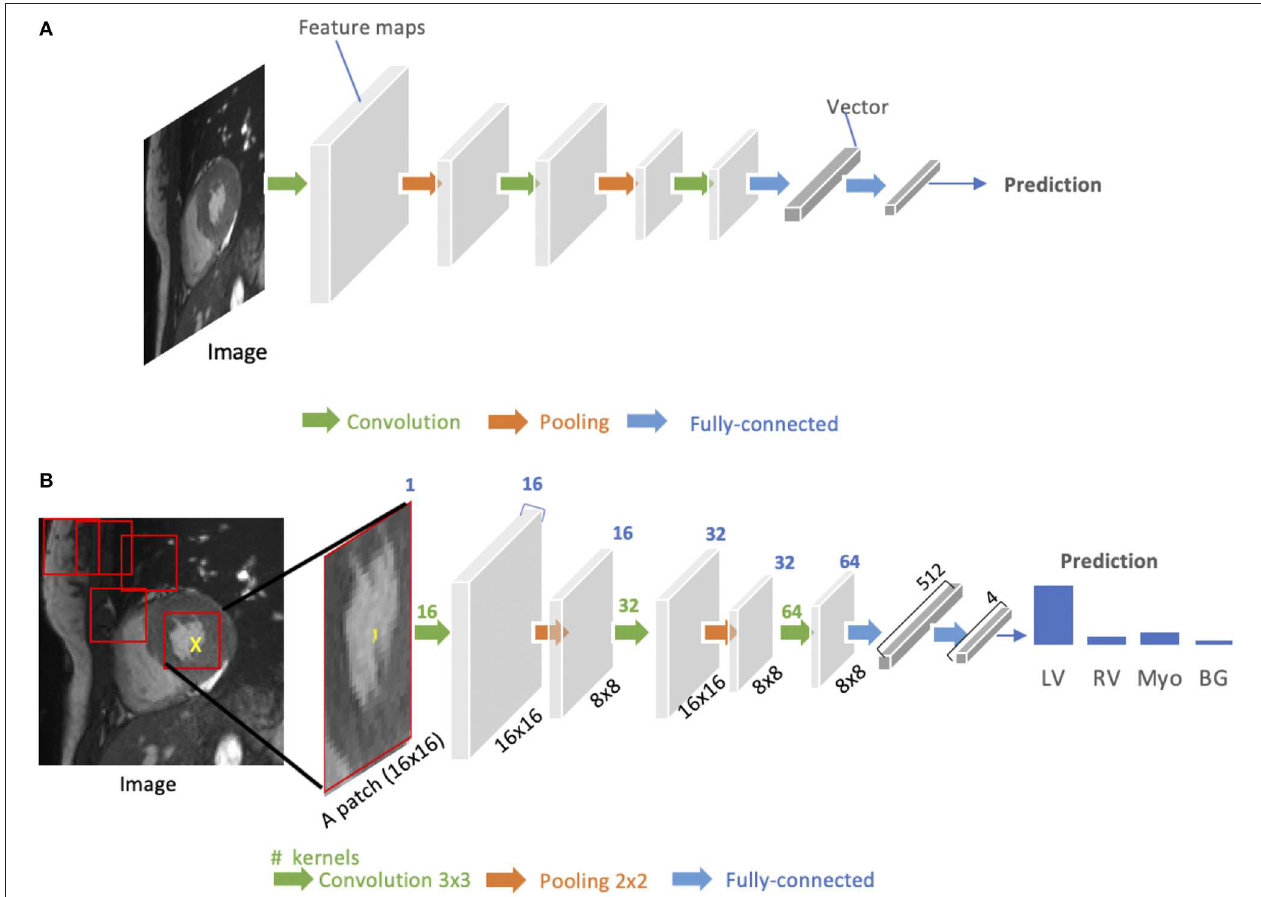
FIGURE 3 | (A) Generic architecture of convolutional neural networks (CNN). A CNN takes a cardiac MR image as input, learning hierarchical features through a stack of convolutions and pooling operations. These spatial feature maps are then flattened and reduced into a vector through fully connected layers. This vector can be in many forms, depending on the specific task. It can be probabilities for a set of classes (image classification) or coordinates of a bounding box (object localization) or a predicted label for the center pixel of the input (patch-based segmentation) or a real value for regression tasks (e.g., left ventricular volume estimation). (B) Patch-based segmentation method based on a CNN classifier. The CNN takes a patch as input and outputs the probabilities for four classes where the class with the highest score is the prediction for the center pixel (see the yellow cross) in this patch. By repeatedly forwarding patches located at different locations into the CNN for classification, one can finally get a pixel-wise segmentation map for the whole image. LV, left ventricle cavity; RV, right ventricle cavity; BG, Background; Myo, left ventricular myocardium. The blue number at the top indicates the number of channels of the feature maps. Here, each convolution kernel is a 3 × 3 kernel (stride = 1, padding = 1), which will produces an output feature map with the same height and width as the